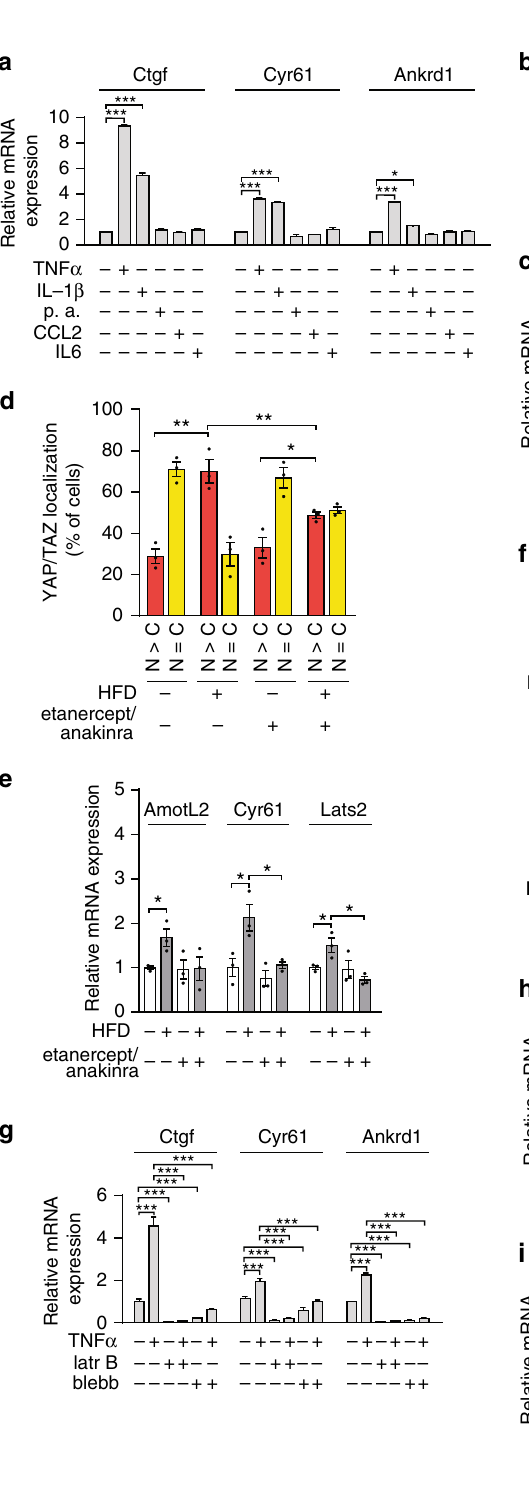
siRNA-mediated suppression of c-Jun affects TNF α - and IL-1 β - induced YAP/TAZ target gene expression. We found that suppression of c-Jun expression attenuated TNF α - and IL-1 β - induced YAP/TAZ target gene expression (Fig. 6d and Supple- mentary Fig. 6e), which indicates that JNK and c-JUN mediate TNF α -induced YAP/TAZ transcriptional activity. Taken together, these data suggest that RhoA-mediated actomyosin